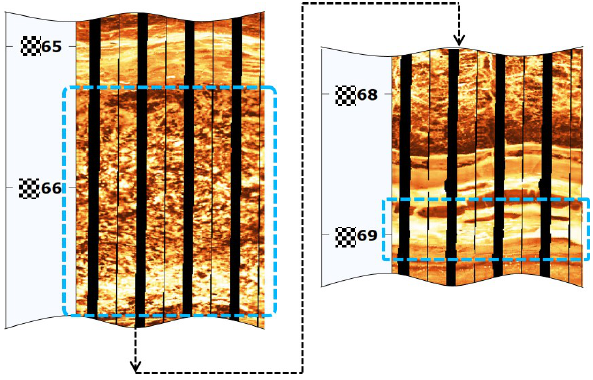
Figure 3. Example of breccias developed due to cavity